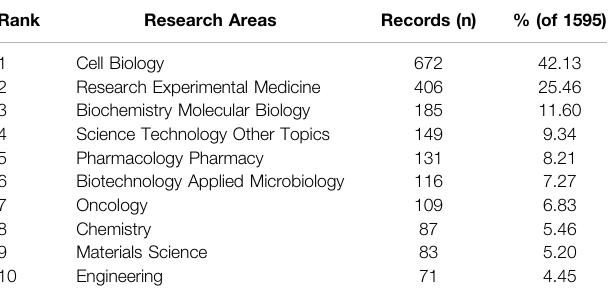
TABLE 3 | The top 10 well-represented research